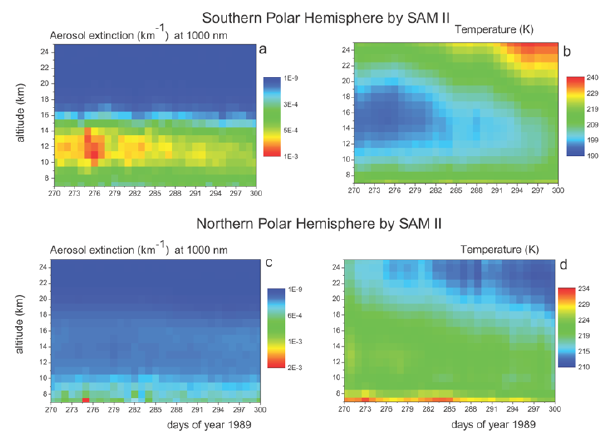
Fig. 5. Variations of the aerosol extinction at wavelength of 1000nm and the temperature over polar hemispheres during the end of September till the end of October 1989. Upper panel: variations of atmospheric parameters over the Southern Hemisphere. Lower panel: the same but for the Northern Hemisphere. Logarithmic color scale of temperature changes is shown on the right of each